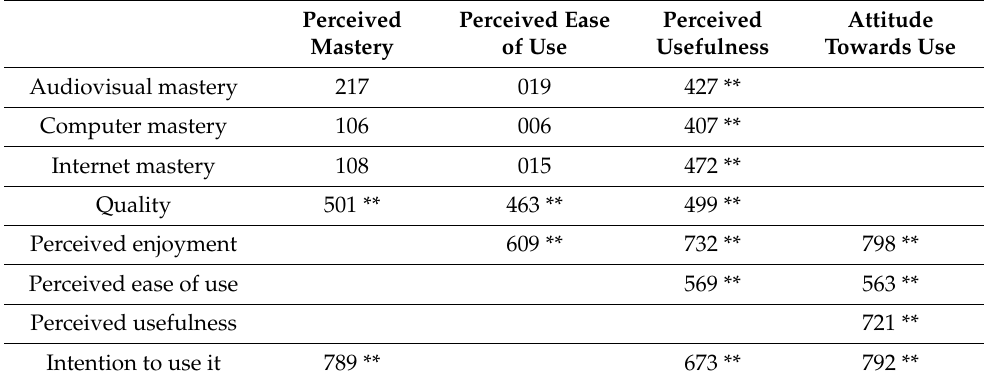
Table 8. Pearson’s correlations between different dimensions. (note: ** = significant at 0.01, moderate or